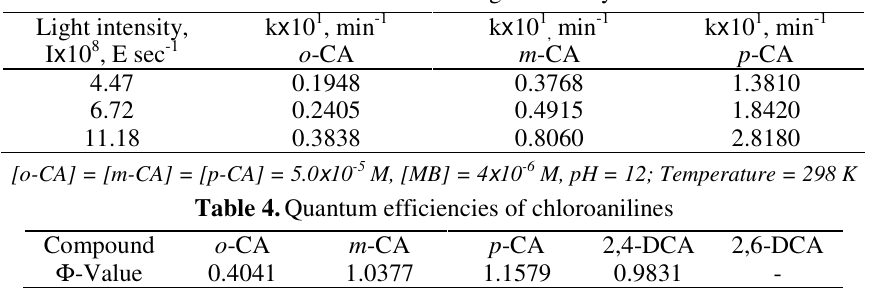
Table 3. Effect of the light intensity